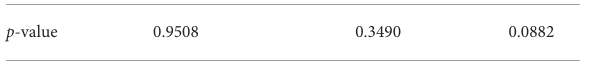
TABLE 4 Residual assumption test ARIMA(1,1,0)